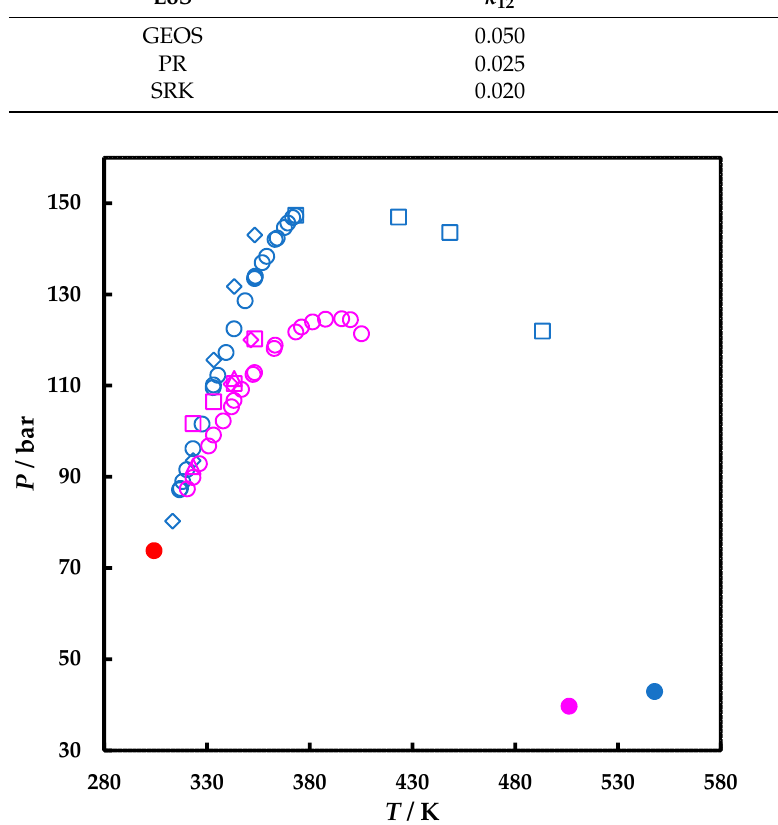
Figure 4. P – T fluid phase diagram of the carbon dioxide (1) + isobutanol (2) and carbon dioxide (1) + tert -butanol (2) systems. Critical points (CP) of pure components: ● , CP CO 2 [56]; ● , CP isobutanol [56]; ● , CP tert -butanol [56]. CP CO 2 + isobutanol: ○ , this work; □ , [26]; ◊ , [27]. CP CO 2 + tert -butanol: ○ , this work; □ , [28]; ◊ , [29]; ∆ , [30].